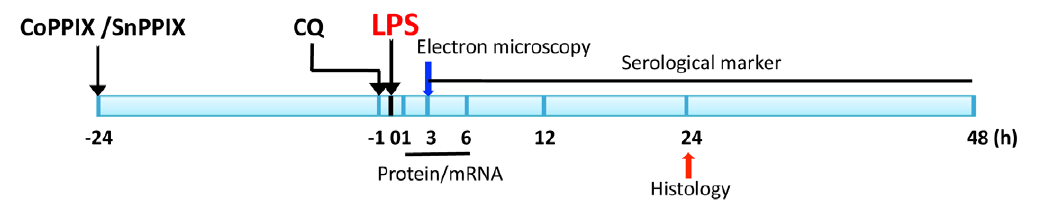
Figure 1. Time line illustrating the experimental design.